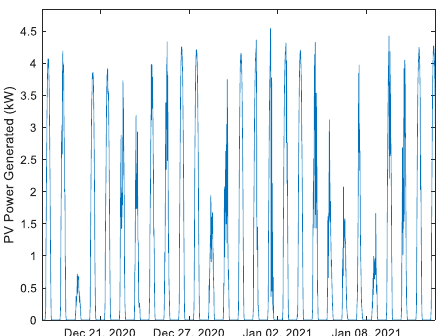
Figure 4. PV power Figure 4. PV power generated. Figure 4. PV power generated.